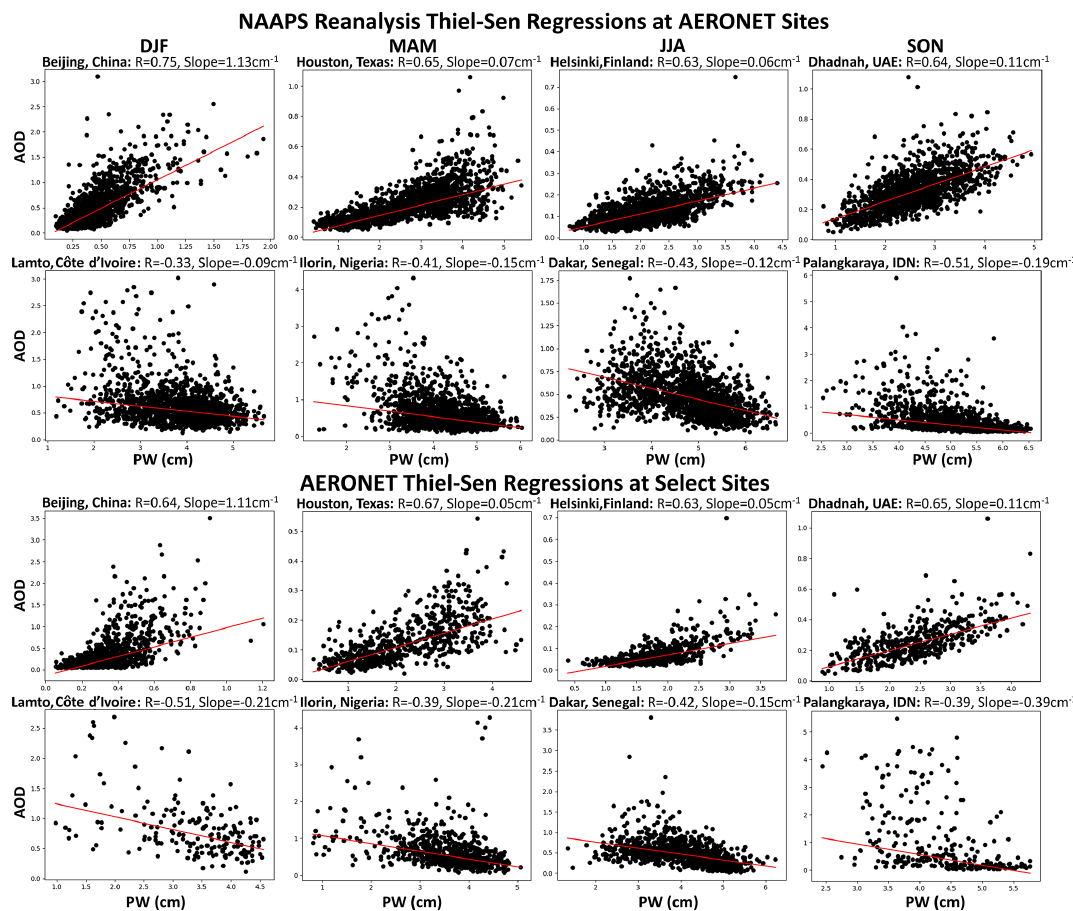
Figure 10. Seasonal examples of NAAPS-RA and AERONET Theil–Sen regression calculations for positive-correlation locations (Beijing, Houston, Helsinki, Dhadnah) and negative-correlation locations (Lamto, Ilorin, Dakar, Palangkaraya). The black dots are the AOD and PW pairs from the NAAPS-RA or AERONET, and the red line is the Theil–Sen fitting, which is the median of the slopes for the range of data pairings. The location name, correlation coefficient ( R ), and the Theil–Sen slope (Slope) are included with each